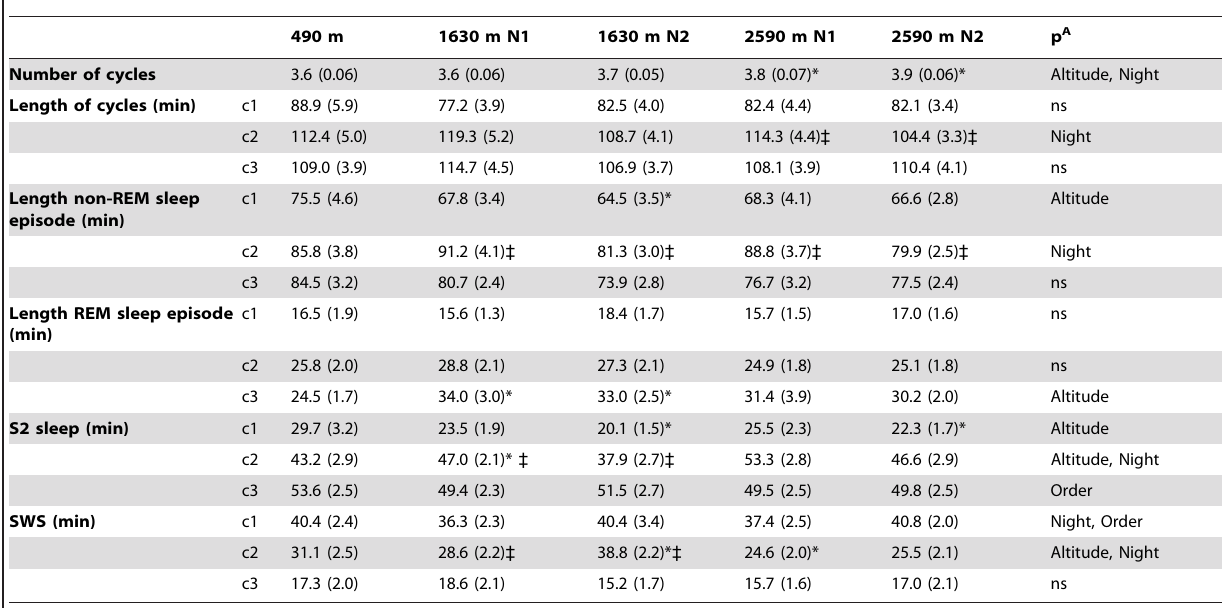
Table 1. Sleep cycle